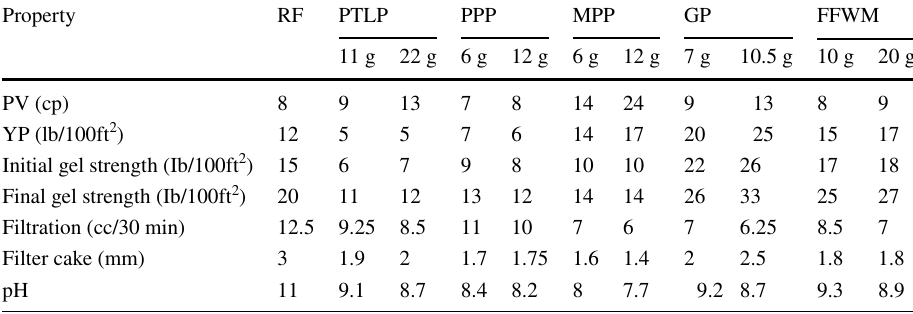
Table 3 Effect of variation in the concentration of various food waste products on properties of water-based mud